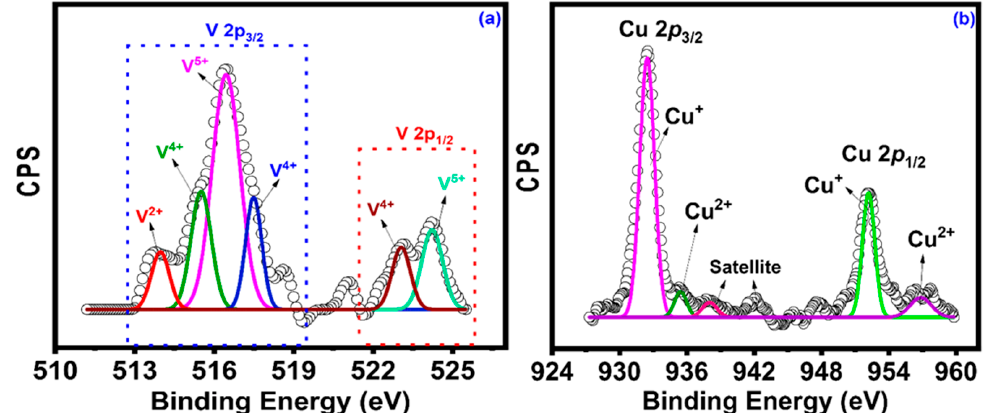
Figure 7. ( a ) V 2p core-level XPS spectra and ( b ) Cu 2p core-level XPS